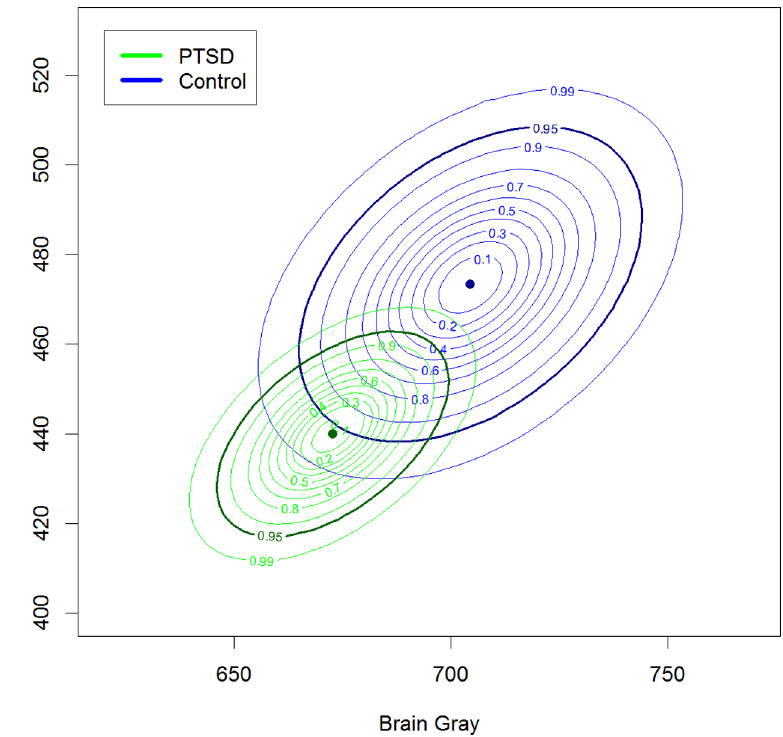
Figure 2. Corpus callosum. Level curves of the a posteriori distribution of mean white matter and gray matter area in patients with PTSD and controls. The darker curve represents the 95% confidence interval.